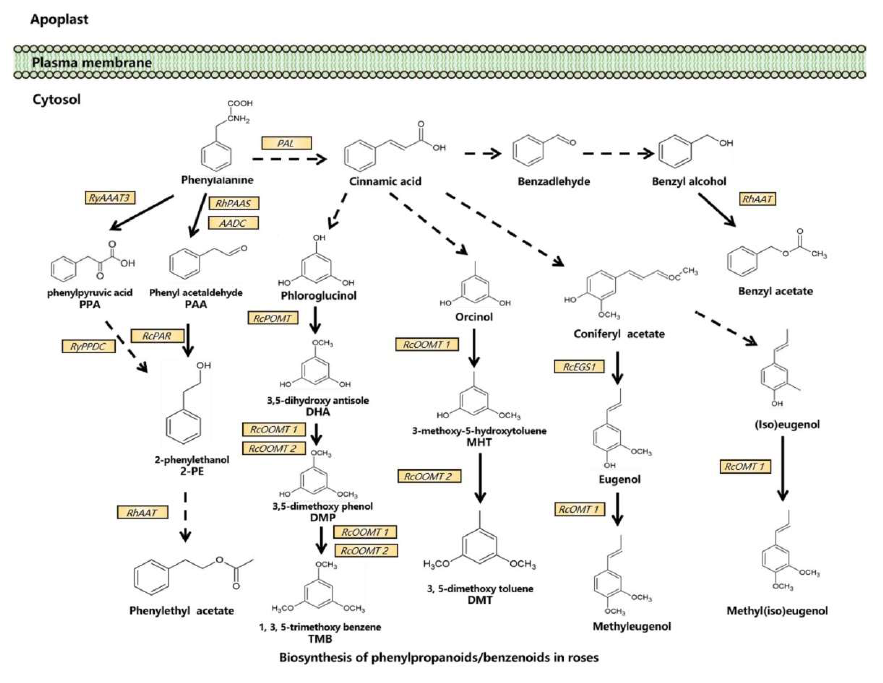
Figure 1. Synthesis pathways of floral scents in roses. ( A ) The biosynthesis pathway of terpenoids in roses. ( B ) Biosynthesis pathway of phenylpropanoids/benzenoids in roses. Solid lines indicate established biochemical reactions, and broken lines indicate possible steps. G3P: glyceraldehyde-3- phosphate; DXS: 1-deoxy-D-xylulose-5-phosphate synthase; DXR: 1-deoxy-D-xylulose-5-phosphate